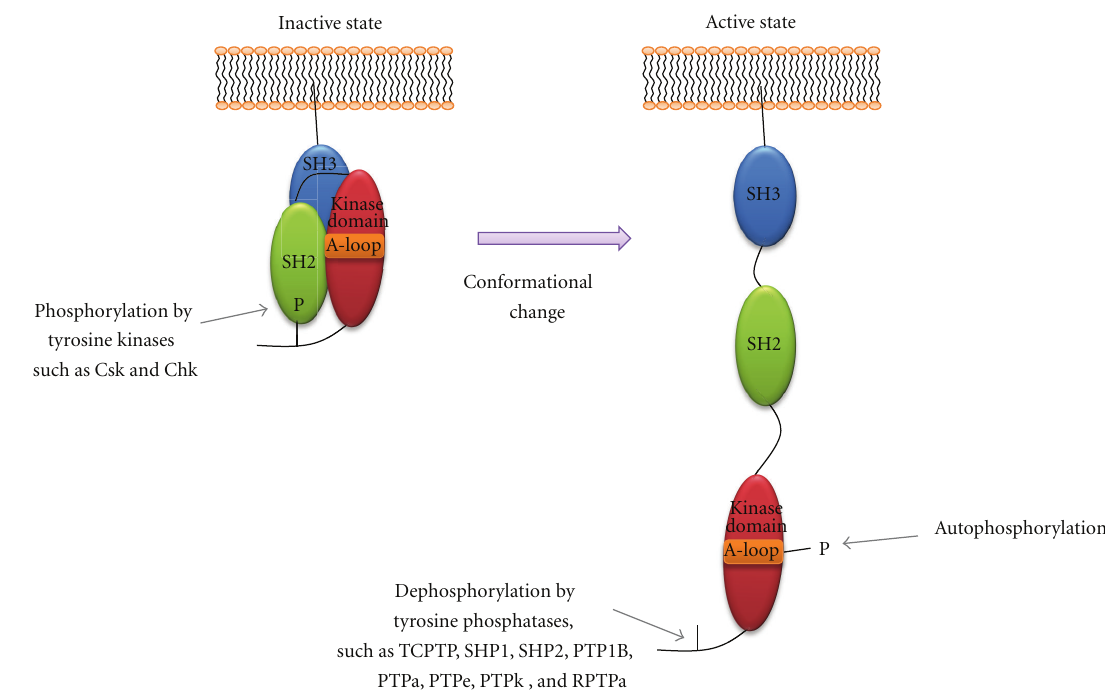
Figure 2: Schemata of conformational changes of